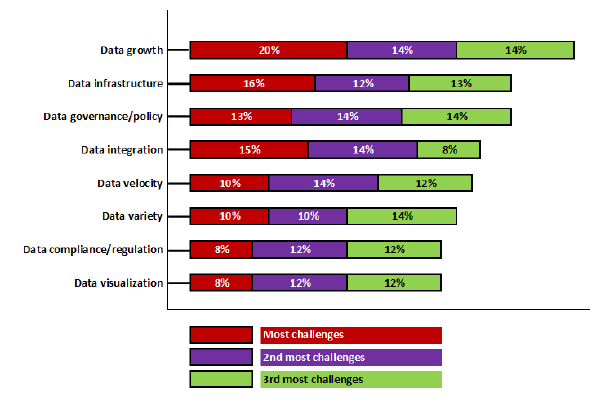
Figure 3: Challenges in Big Data